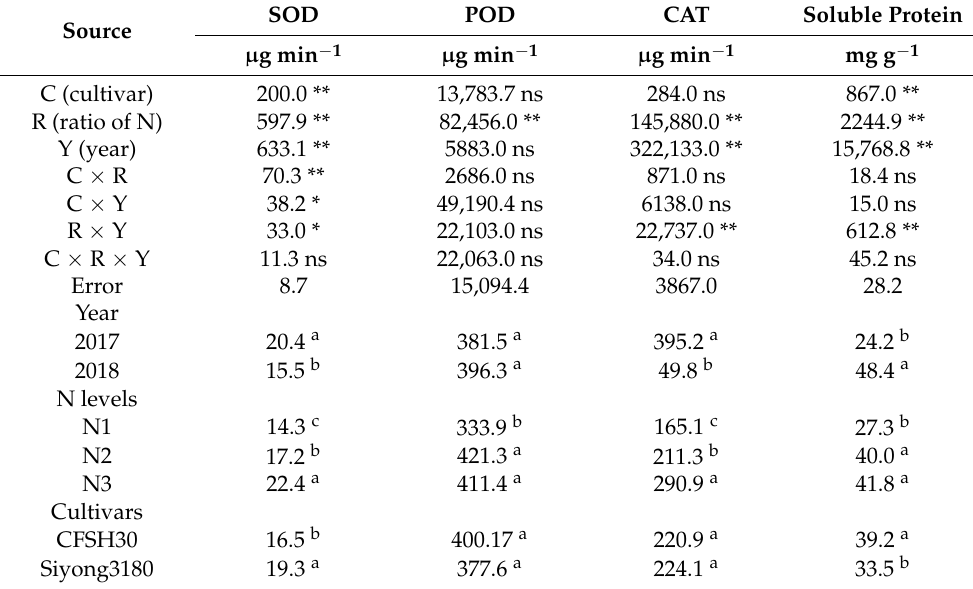
Table 6. Significance test for source of variation (mean square), and their effects on antioxidant enzyme activity during two growing